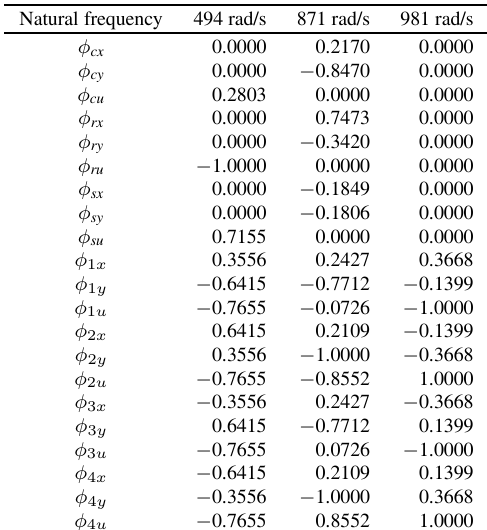
Table 4 The three modes of the drive system for N = 4